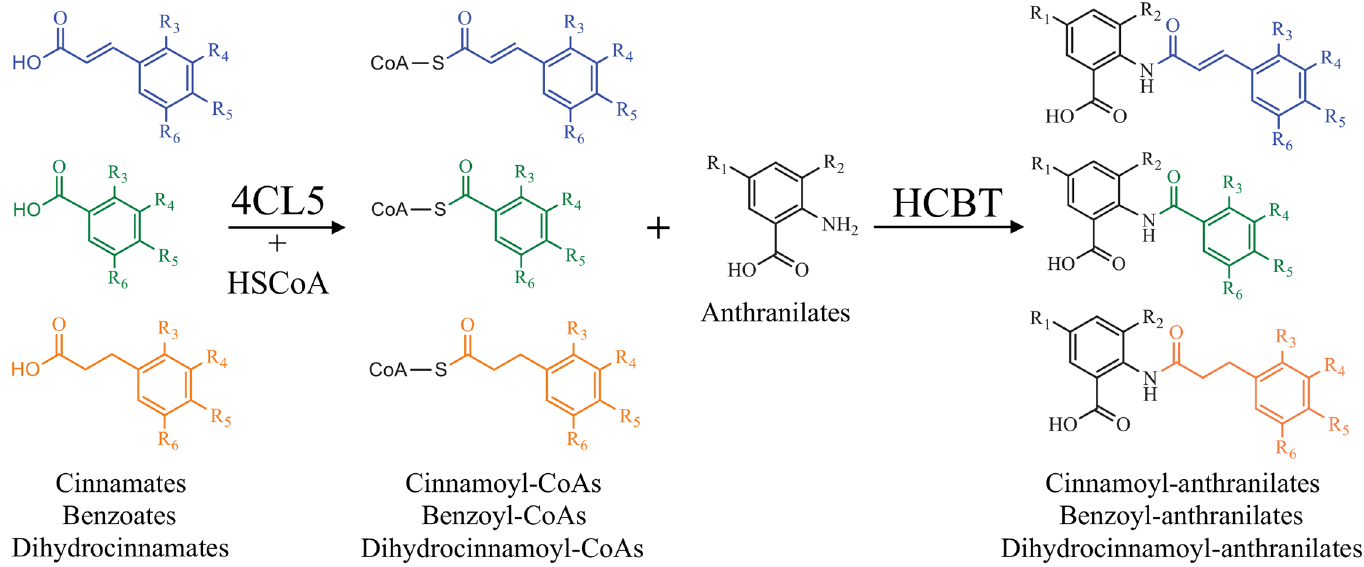
Fig 2. Strategy used for the biological synthesis of cinnamoyl, dihydrocinnamoyl, and benzoyl anthranilates. Diagram of the reactions catalyzed by 4CL5 and HCBT in the yeast strain engineered for the production of various cinnamoyl, dihydrocinnamoyl, and benzoyl anthranilates upon feeding with cinnamates, dihydrocinnamates, or benzoates (donors); and with anthranilates (acceptors). HSCoA, Coenzyme A.